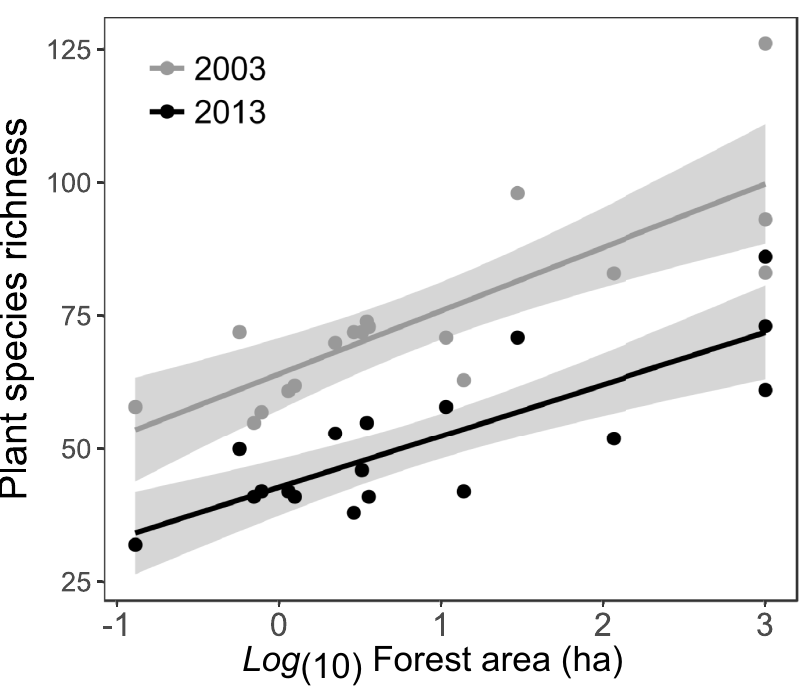
Fig 2. Plant species richness. Plant species richness-area relationships for the same Chaco Serrano forest fragments in 2003 (grey line and CI) and 2013 (black line and CI). CI = 95% Confidence interval.